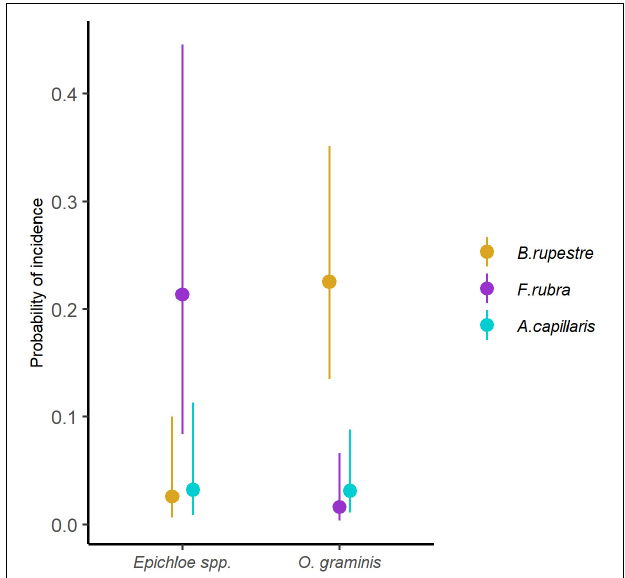
FIGURE 10 | Probability of incidence of Epichloë spp. and Omnidemptus graminis in the aboveground tissues of the most common grasses of high-diversity